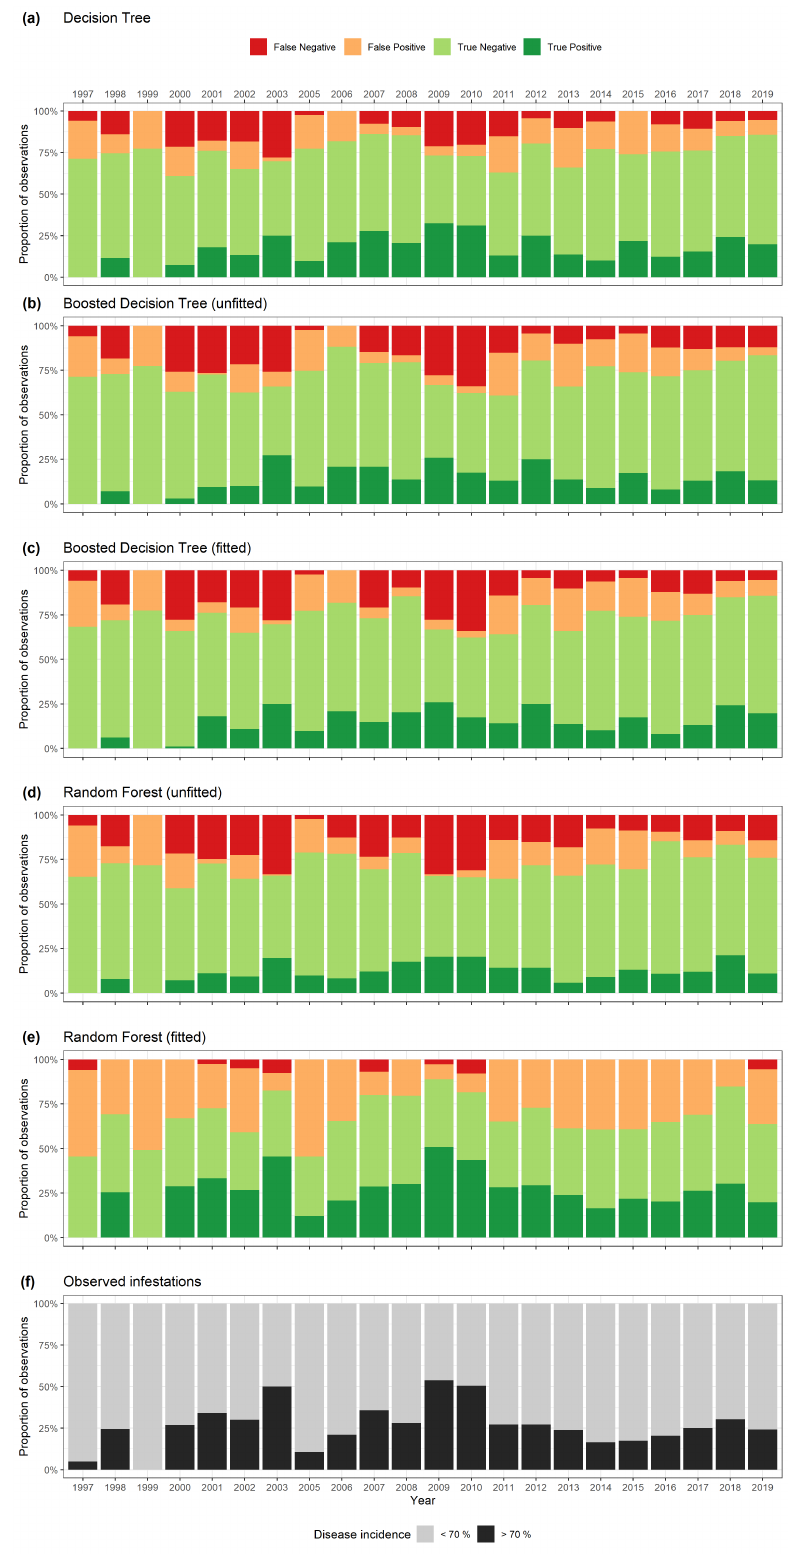
Figure 4. Observed disease incidence ( f ) and quality of the prediction of varying machine learning procedures ( a – e ) over the studied period from 1997 to 2019 in the study area. The procedures marked as “fitted” were adopted to reach a high receive operating characteristic area under the curve (ROC AUC) instead of a high